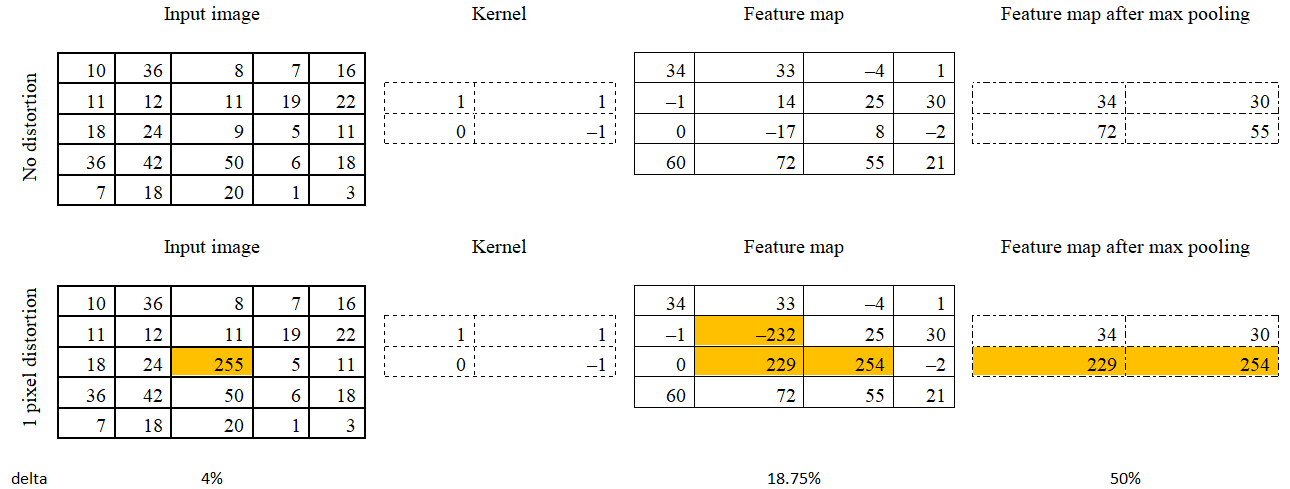
Figure 1. Changes in a convolutional network from a one-pixel attack.